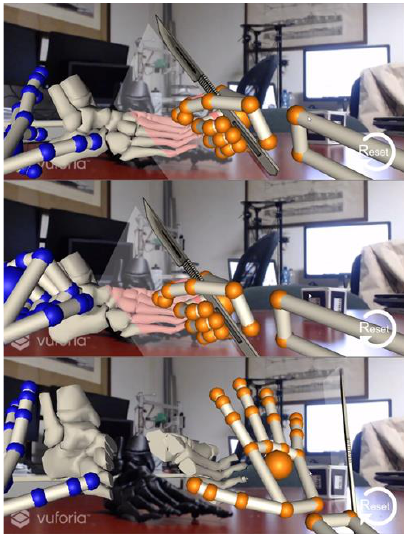
Figure 11. Virtual hand used for cutting plane detection.